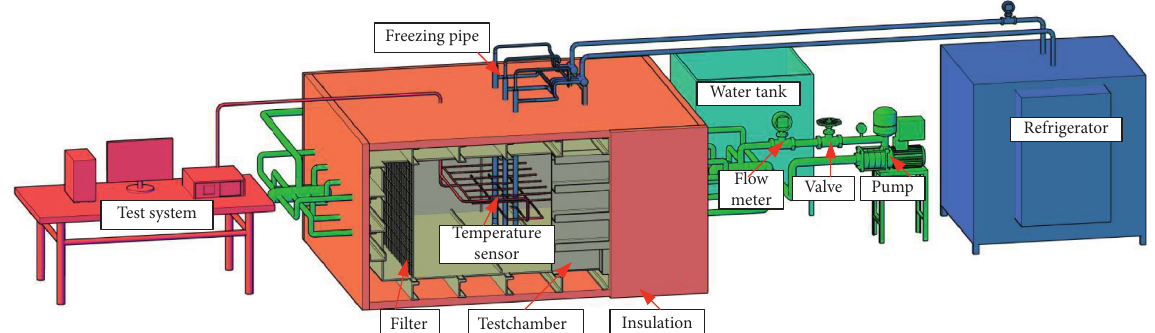
Figure 2: Three-dimensional (3D) schematic of the large-scale physical model test system.